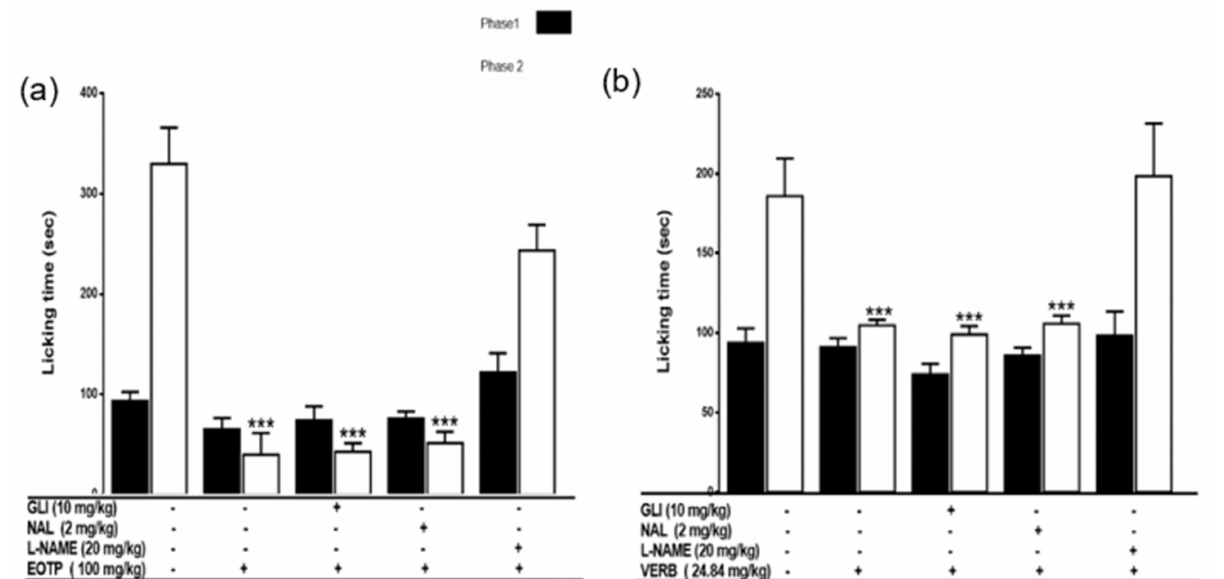
Figure 3. The mechanism of action of the antinociceptive effects of EOTP and VERB was evaluated by a formalin pain biphasic model in the three graphics that show both phase 1 and phase 2. ( a ) The mechanism of action of EOTP (100 mg/kg). ( b ) Determination of the antinociception mechanism of action of VERB (24.8 mg/kg). Additional groups of mice received an inhibitor such as L-NAME (20 mg/kg, an inhibitor of nitric oxide synthase and guanylate cyclase), GLI (20 mg/kg, a K + channel sensitive to ATP) or NAL (2 mg/kg, an antagonist of opioid receptors). The data represent two different experiments ( n = 8). The results represent the mean ± SEM. (***) represents p < 0.05 compared with the control